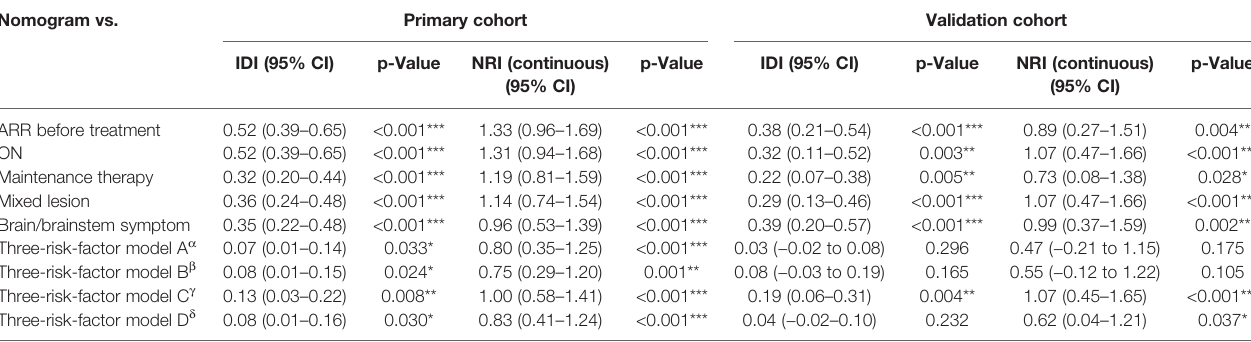
TABLE 6 | Comparison of nomogram with other predictive factors of relapse. Nomogram vs.